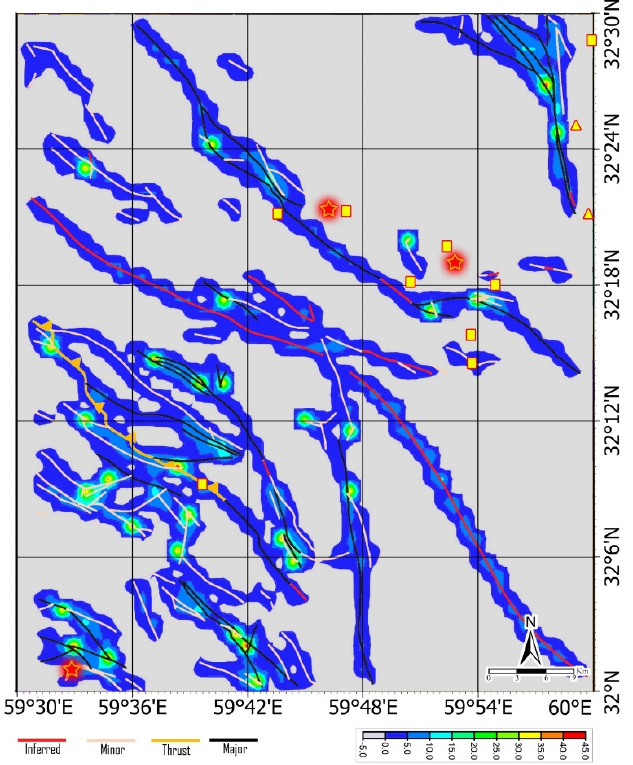
Figure 9. Lineament Factor (LF) map of the study area.